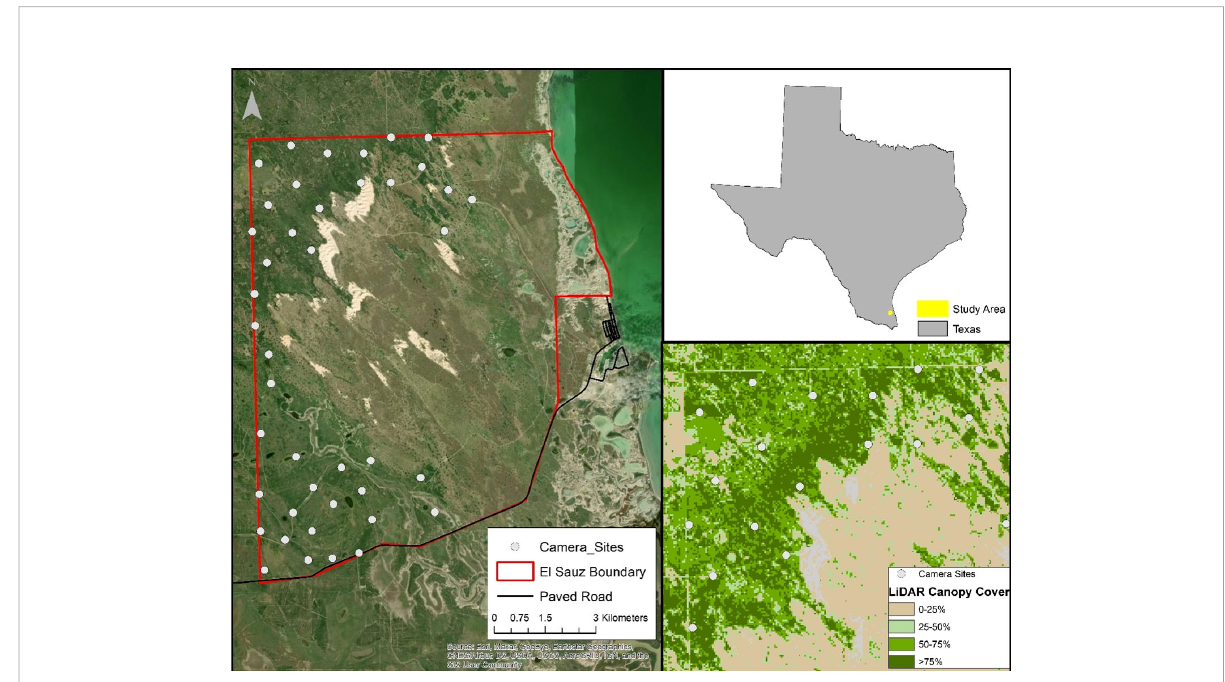
FIGURE 1 Map of camera trap array (n = 42 stations; left panel) to determine population density and population size of ocelots Leopardus pardalis pardalis ) on the East Foundation ’ s El Sauz Ranch in Willacy and Kenedy counties in southern Texas (upper-right panel) from September 2020 to May 2021. The lower-right panel depicts an example of the zoomed-in view of the LiDAR-derived woody and herbaceous canopy cover surrounding the camera trap